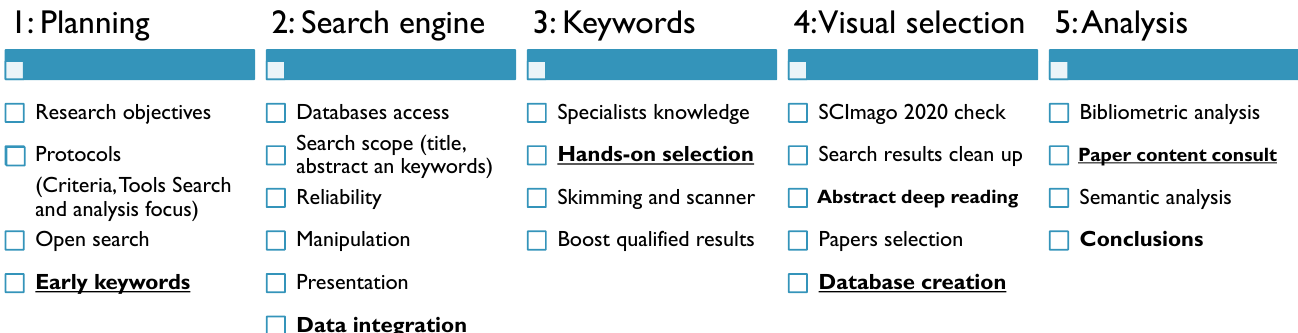
Figure 1. Steps methodology diagram.